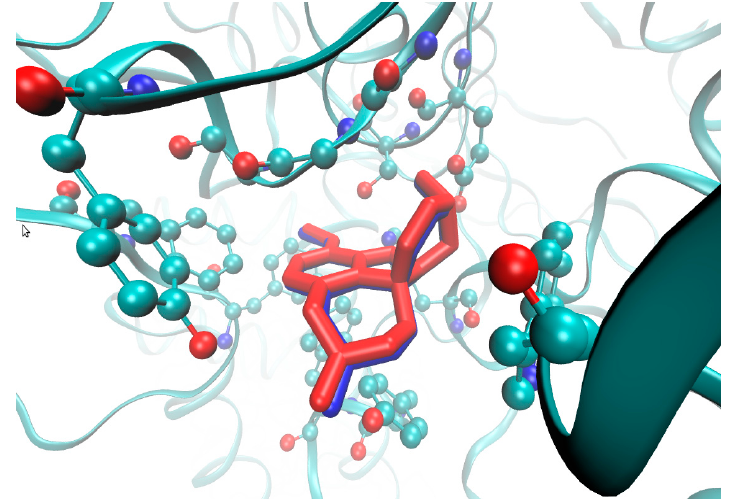
Figure 6. Structure of rhAChE bound with galanthamine (blue) and docked with AutoDock Vina (red) in active site of enzyme chain A (depicted amino acid residues of Trp86, Gly120-122, Tyr124, Glu202, Ser203, Phe295, Phe297, Tyr337, Phe338, His447).